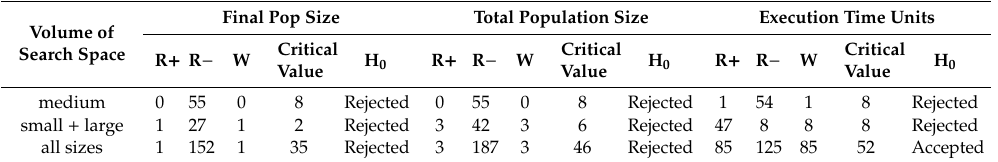
Figure 7. Mean results over the problems grouped by the size of the search space volume: ( a ) Final size of the population (actual); ( b ) Total size of the population (actual); ( c ) Execution time (estimate). Table 10. Wilcoxon test as regards (final and total) population sizes and execution time. R − is the sum of ranks of comparisons where HVcMO20a outdoes HillVallEA19, and R + is the opposite sum. If the W statistic is equal or less than the critical value, the null-hypothesis is